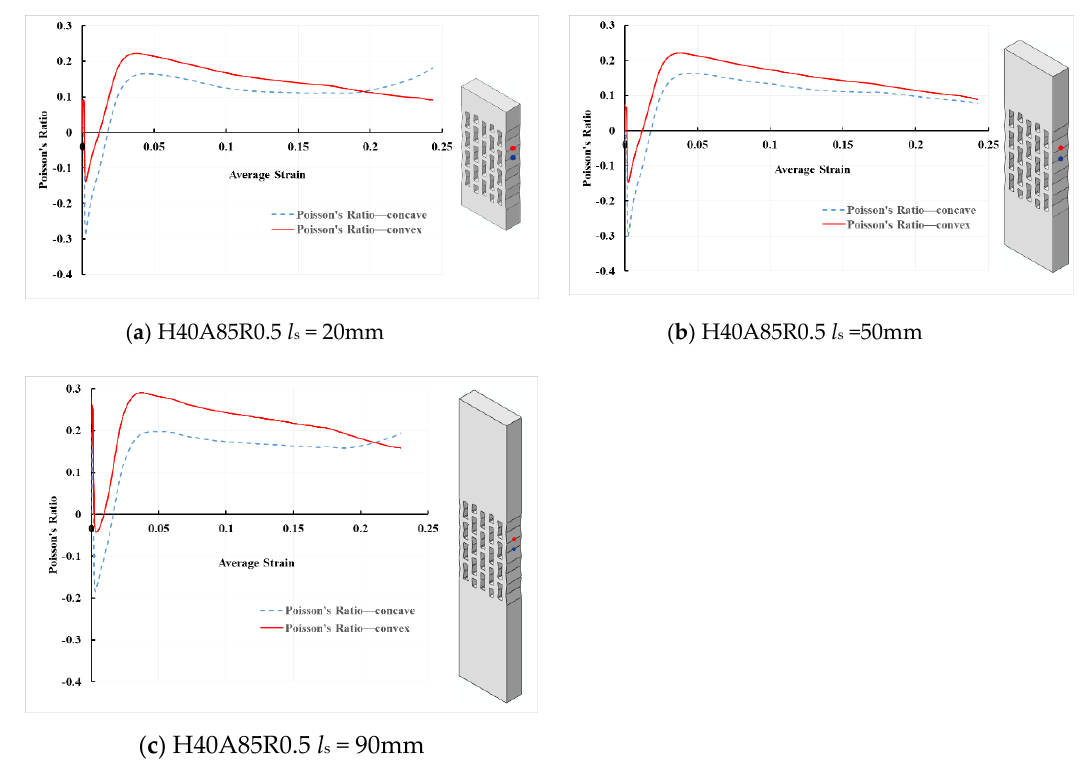
Figure 24. Poisson’s ratio curves of specimens with different solid areas with (a) l s = 20 mm, (b) l s =50 mm and (c) l s = 90 mm .